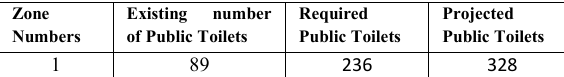
Figure 5: Methodology